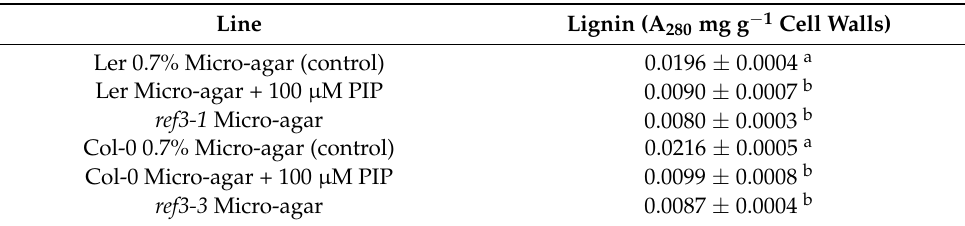
Figure 9. C4H activity of Arabidopsis thaliana Ler, Col-0, ref3-1, and ref3-3 seedlings on 0.7% ( w / v ) Micro-agar (control) after 14 days of culture. Different letters indicate significant differences between means at α = 0.05 level. Table 2. Total lignin of Arabidopsis thaliana wild-type, less-lignin-mutant, and wild-type + PIP on Mico-agar medium.